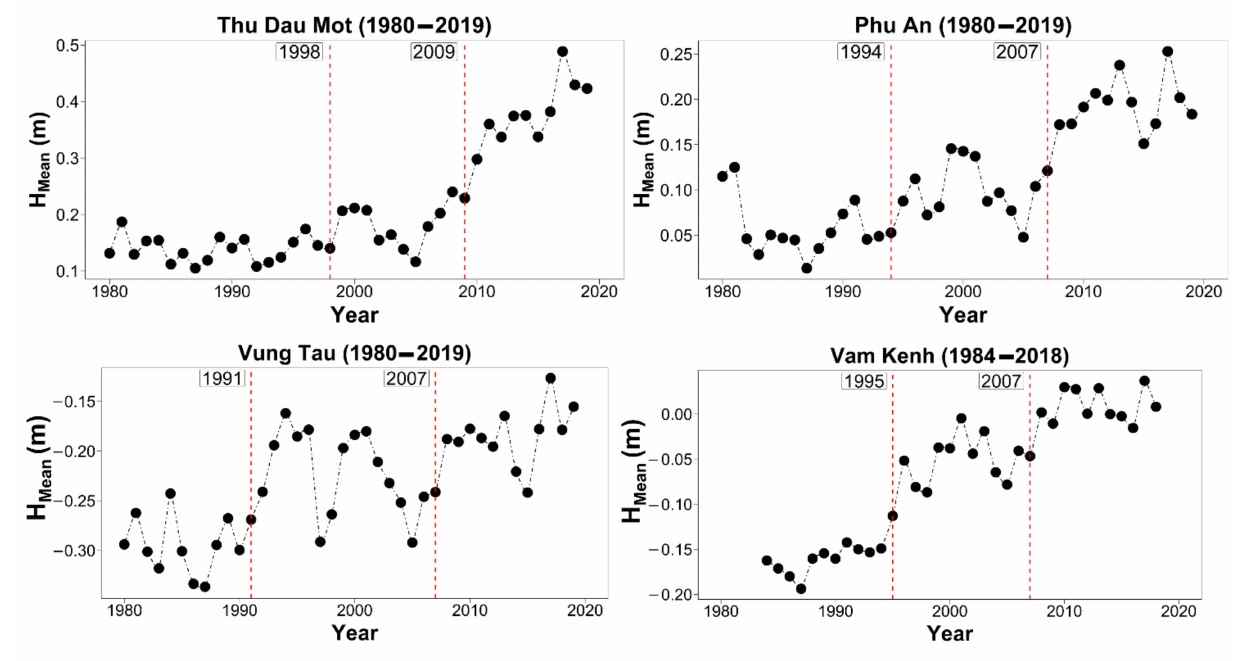
Figure A4. Changepoint years showing the possible shifts in H mean .